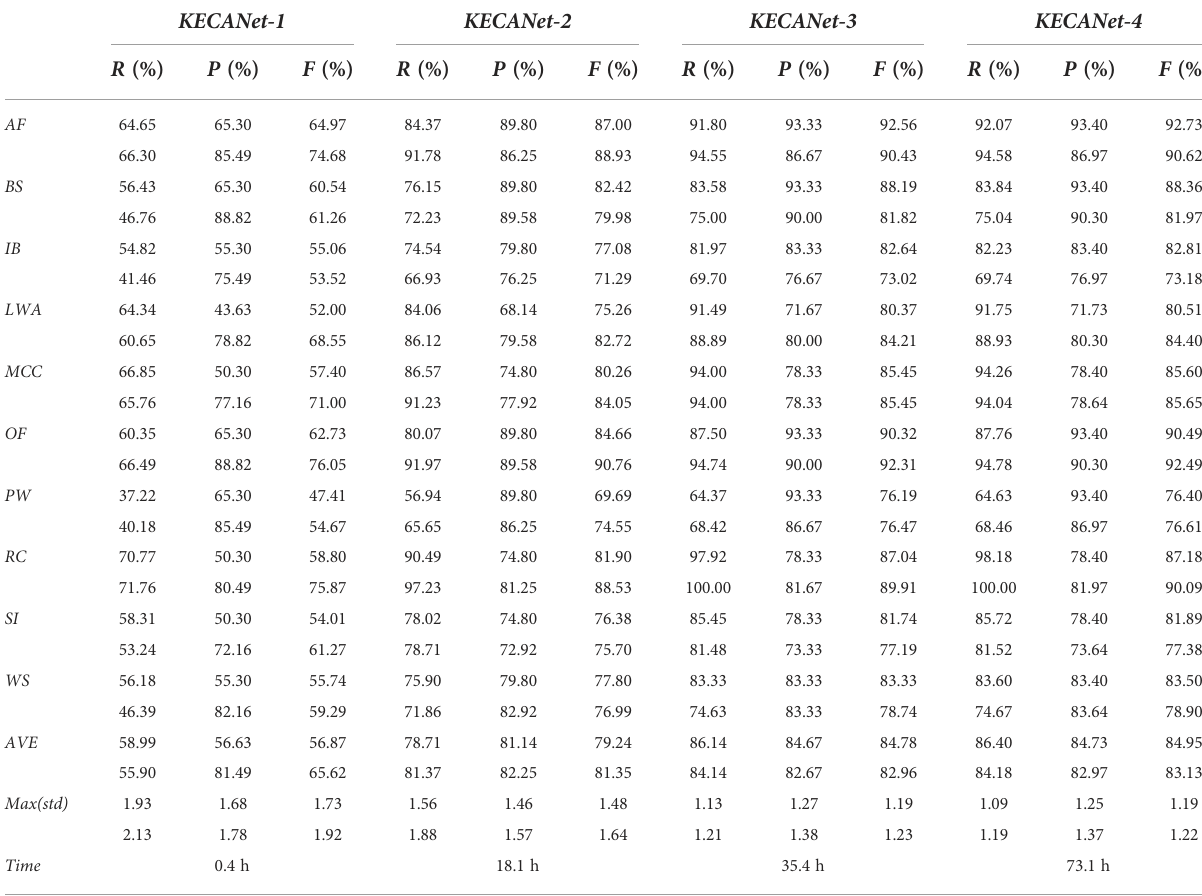
TABLE 3 Classi fi cation performance (%) in WV1 (upper) and WV2 (lower) imagette recognition for KECANet using different